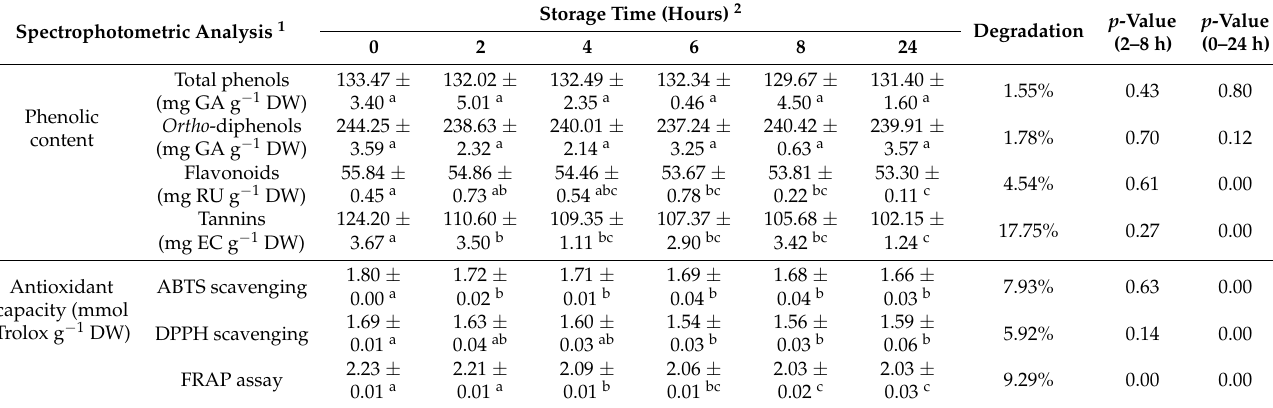
Table 1. Change of phenolic content and antioxidant activity of pomegranate leaf infusion by spectrophotometric assays.